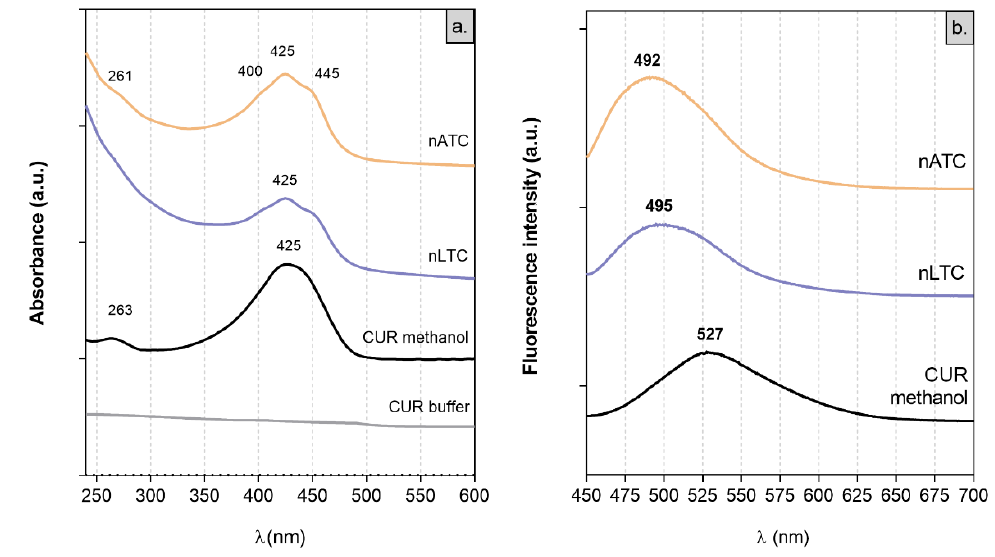
Figure 1. Representative Cryo-EM images of nanovesicles ( a ) nATC, ( b ) nAT, and ( c ) nLTC. White arrows point out CUR crystals and the red ones fused nanovesicles. Absorption spectra: Because of its low solubility, CUR does not present absorption peaks between 250 and 600 nm in buffer tris pH 7.4 [40]. In polar solvents, CUR absorbs visible light because of its conjugated double bonds. In solution, CUR displays keto-enol equilibrium, between a planar enol form and a less polar, more energetic, and angular diketo tautomer, where the conjugation between aromatic rings is interrupted [41]. The λ max absorption at 425 nm of CUR in methanol is ascribed to the enol-monoanion form; the two shoulders at 445 nm and 400 nm observed in nATC and nLTC suspensions are ascribed to the enol and diketo forms, respectively (Figure 2a) [38,40,42]. Fluorescence spectra: the displacement of the tautomeric equilibria of CUR depends